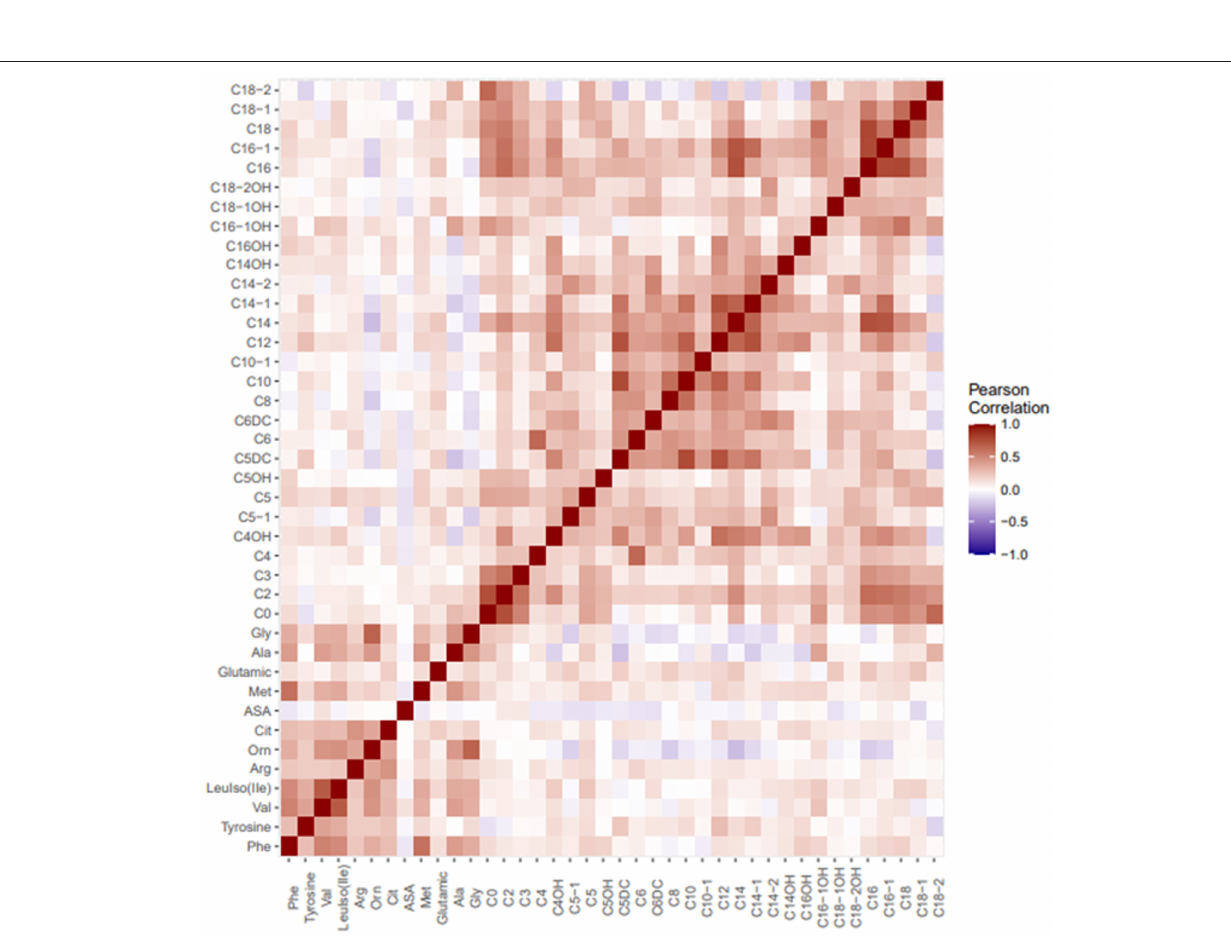
Frontiers in Pediatrics |